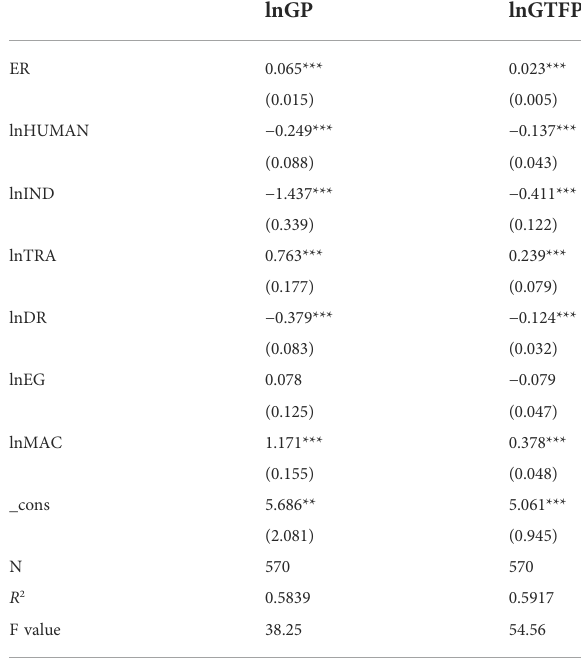
TABLE 2 Estimated results of the fi xed effects panel